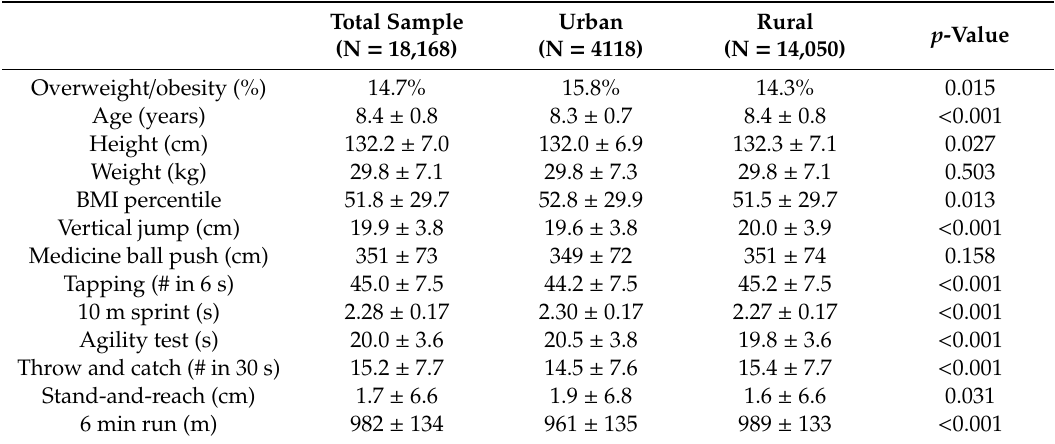
Table 1. Descriptive characteristics. Values are mean ± SD, except for overweight/obesity where prevalence is shown.